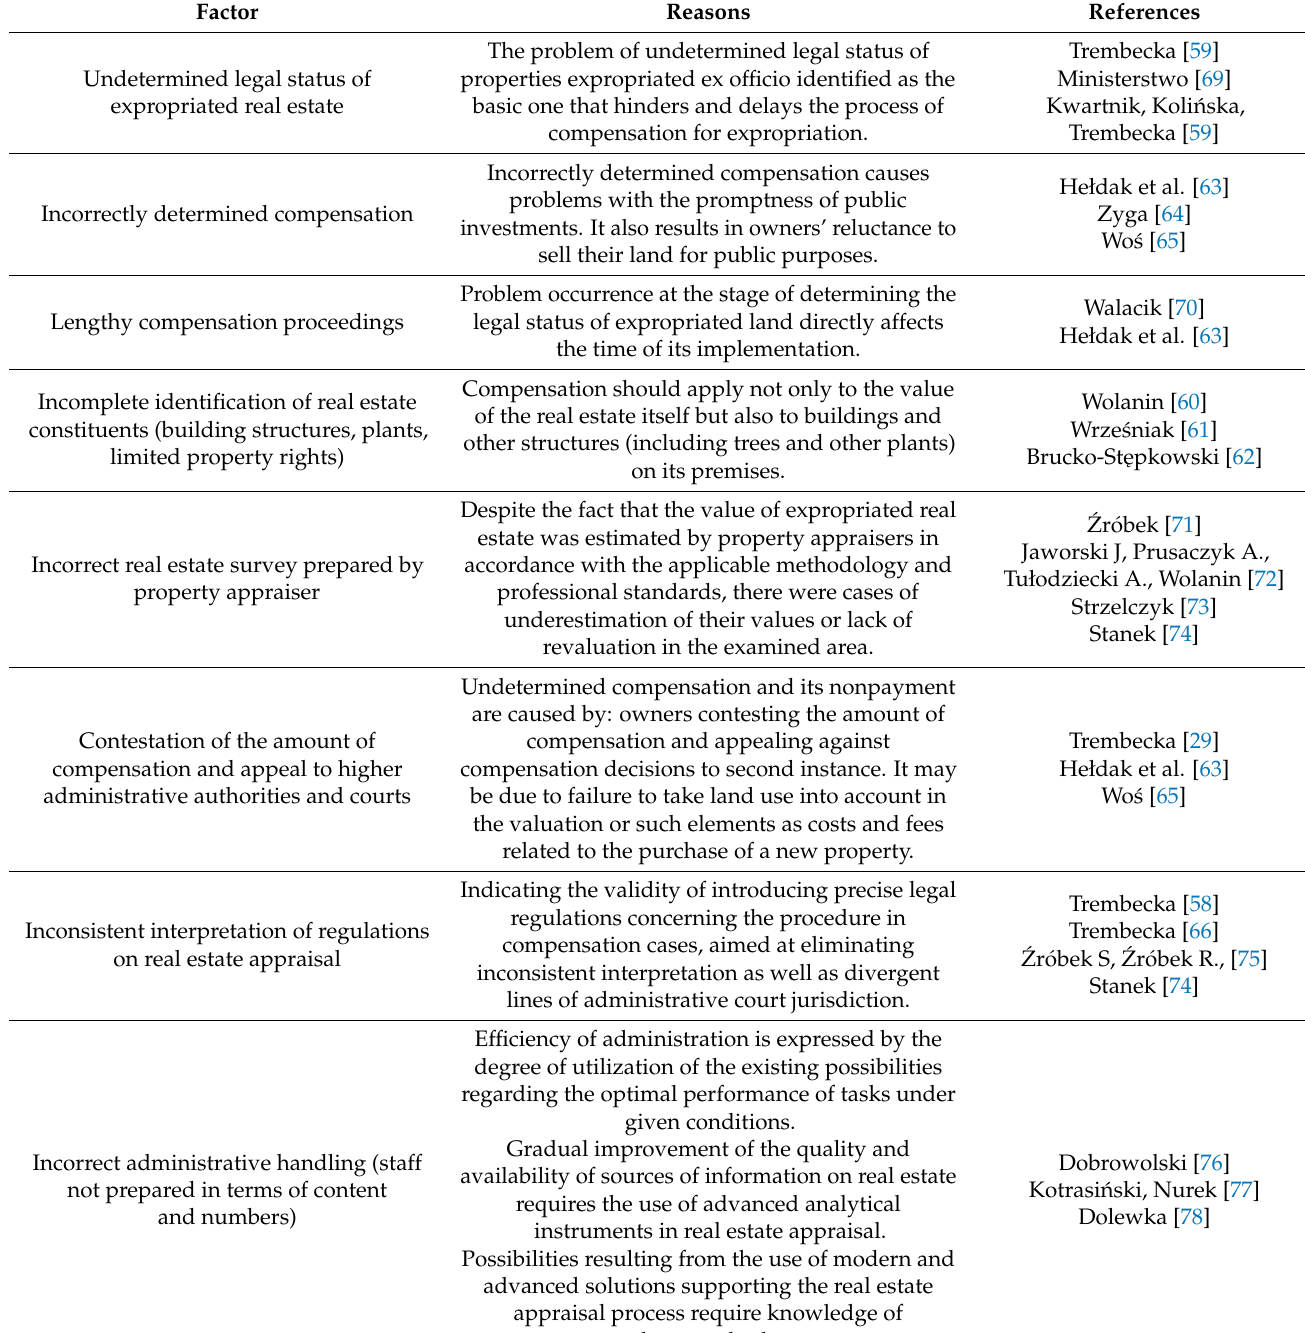
Table 1. Identified barriers to the process of determining compensation for expropriated real estate in